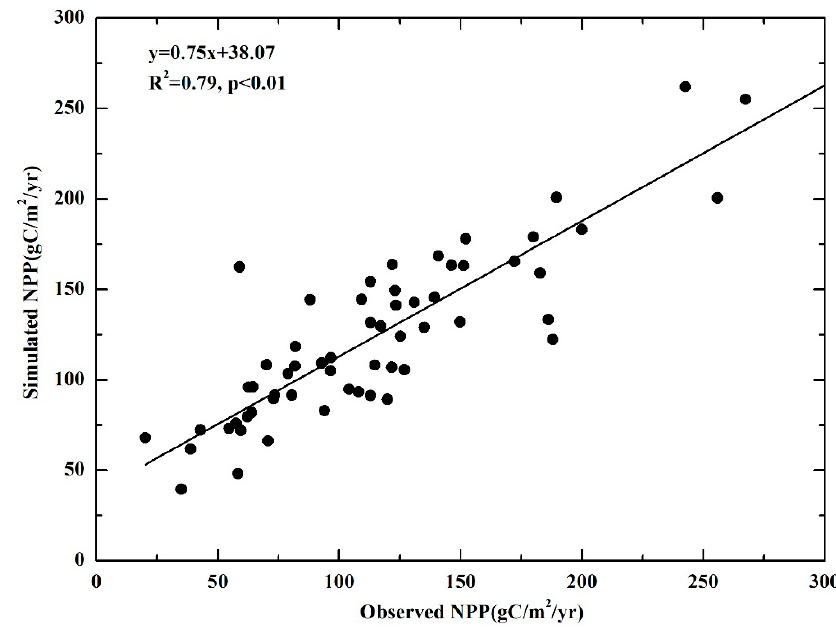
Figure 2. Comparisons of simulated net primary productivity (NPP) from the Carnegie-Ames-Stanford Approach (CASA) model and observed NPP. 133